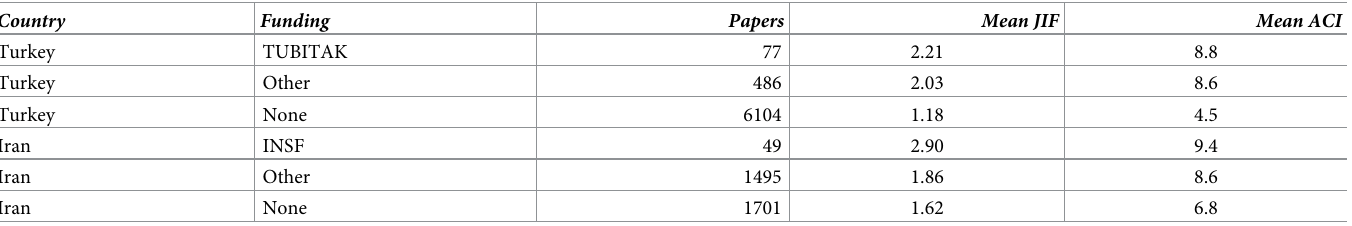
Table 9. Mean Journal Impact Factors (JIF) and Actual Citation Impact (ACI, five years) for Turkish and Iranian domestic mental health disorders papers with dif- ferent sets of funding acknowledgements.